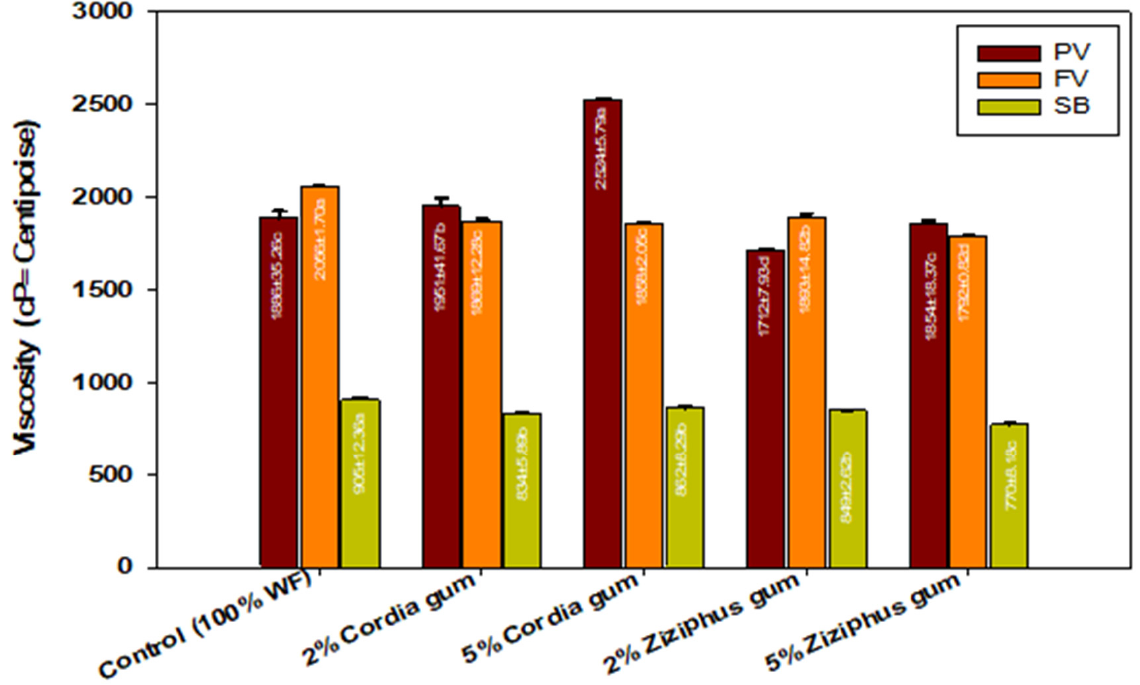
Figure 1. Rapid Visco Analyzer (RVA) pasting properties of wheat flour gels containing different levels of Cordia and Ziziphus gums. PV = peak viscosity; FV = final viscosity; SB = setback viscosity; values followed by different letters in same color bars are significantly different at p ˂ 0.05.